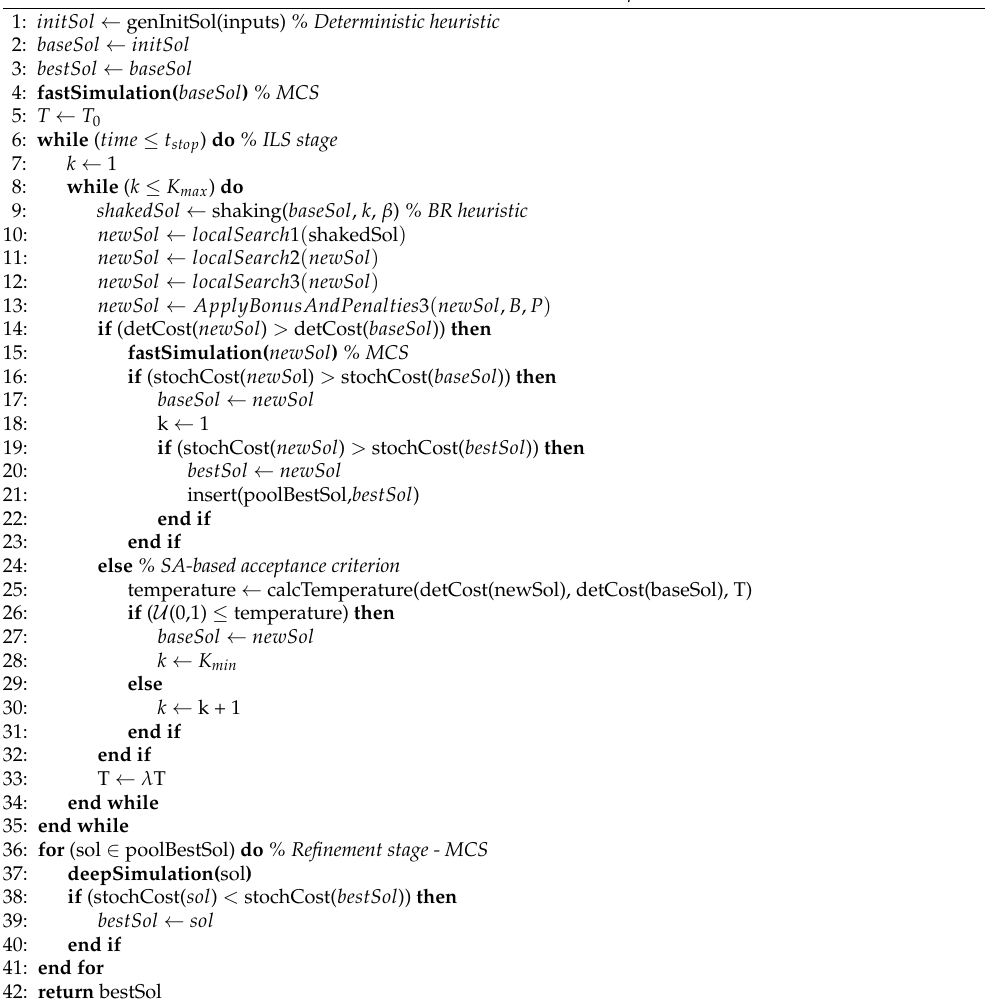
Algorithm 1 BR-ILS Simheuristic ( inputs , β , K max , T 0 , t stop